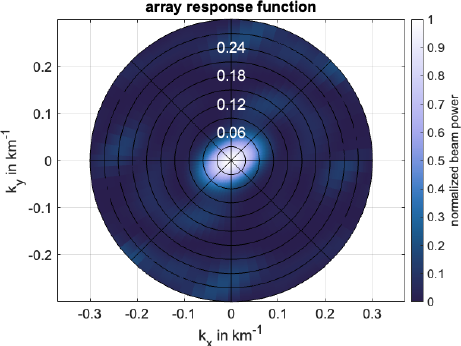
Figure 2. Array response function for the array geometry for 15 of the stations shown in Fig.